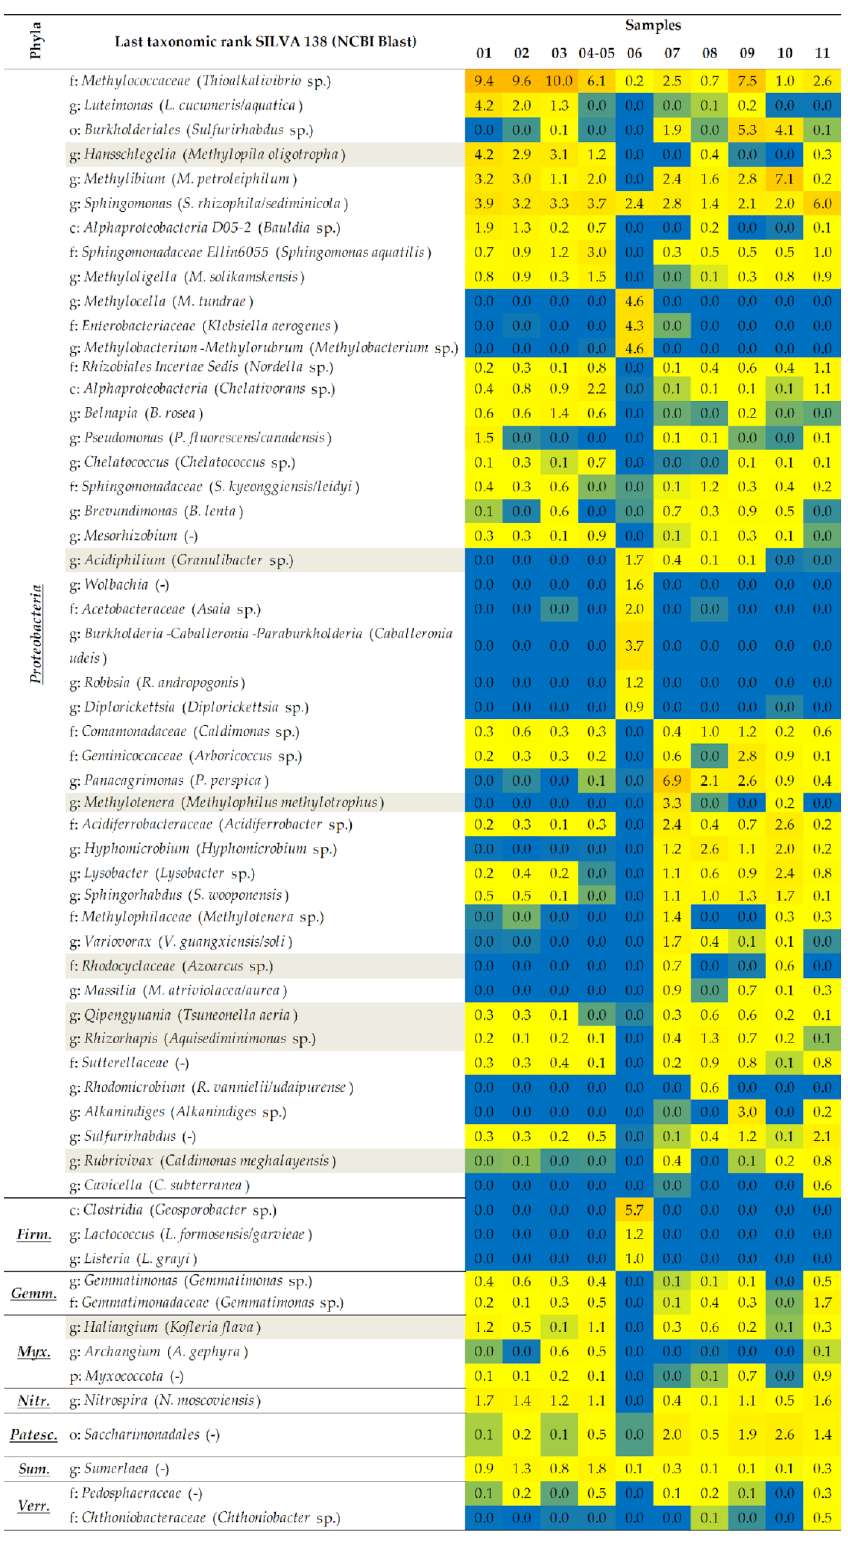
Figure 4. Relative abundance of bacterial taxa at the last taxonomic rank according to the SILVA 138 database and BLAST best top 10 hits in NCBI at the species level. Relative abundance of bacterial taxa are present at all proportion levels, and different colors indicate low or high abundance (blue, yellow, and red colors—lowest, medium, and highest RA, respectively). (p)—phylum; (c)—class; (o)—order; (f)—family; (g)—genus; (-)—not determined. The gray color indicates differences between SILVA